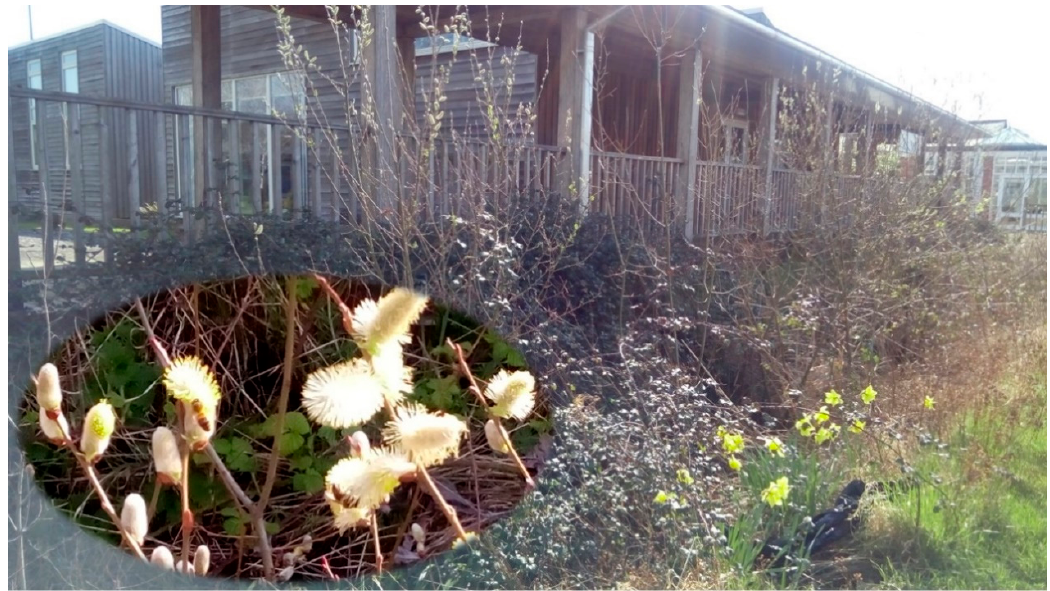
Figure 6. Detail of the swale before maintenance works. Picture taken looking from North-east to South-west from the mid-point of the swale’s length in early Spring 2019.